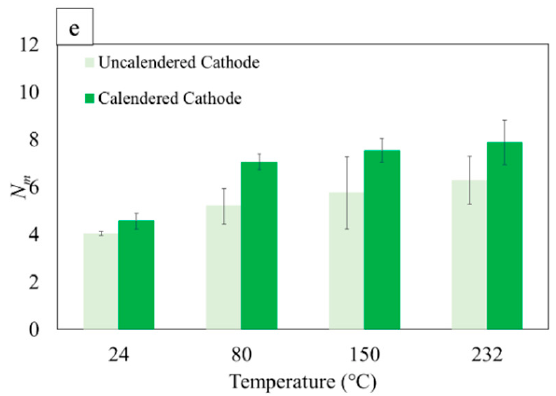
Figure 13. Ionic-resistance maps of uncalendered and calendered cathodes dried at ( a ) 24 ◦ C, ( b ) 80 ◦ C, ( c ) 150 ◦ C, and ( d ) 232 ◦ C, and ( e ) comparison between the average ionic resistances of cathodes before and after calendering.